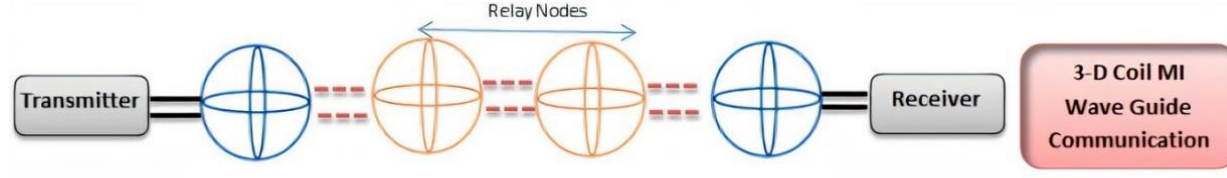
Figure 5. Basic structure of MI waveguide with 3D coils.